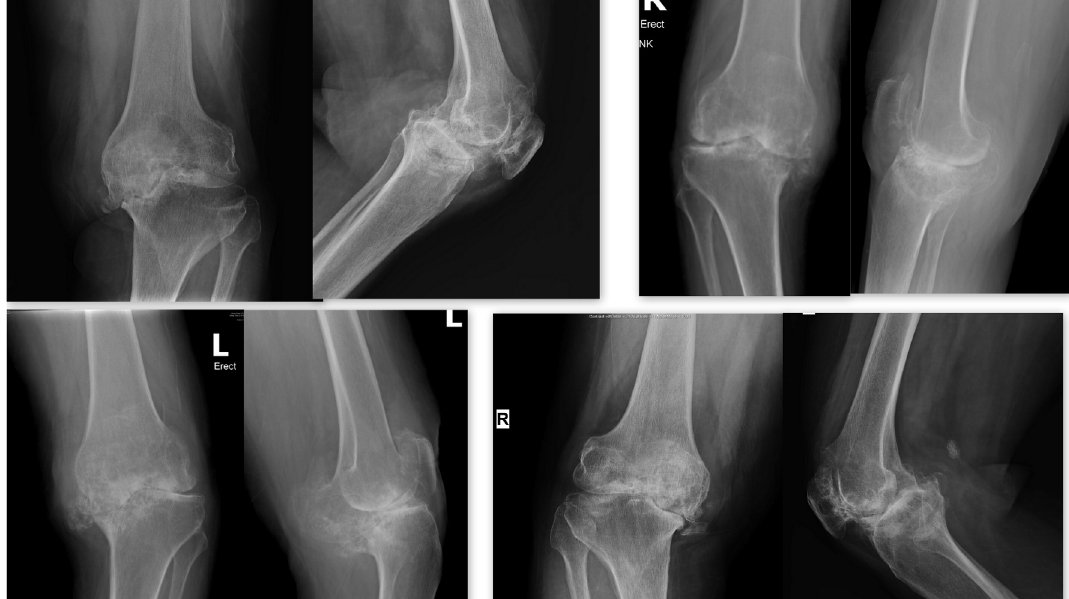
Figure 1. Pre-operative X-rays of patients with severe varus deformity and extensive bone loss from posteromedial condyle.